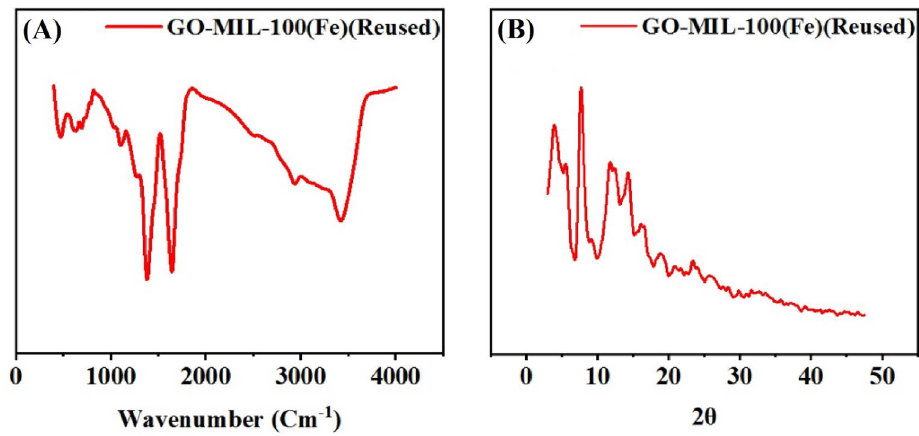
Figure 6. FT-IR ( A ) and PXRD ( B ) spectra of the recovered heterogeneous catalyst after 5th run.